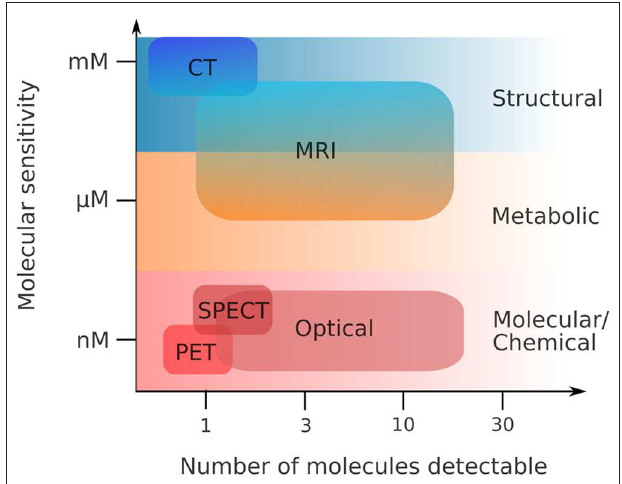
FIGURE 2 | Functional imaging—sensitivity vs. specificity. Same abbreviations as in Figure 1 . Adapted from Pogue et al. [1], with permission from the American Journal of Roentgenology (copyright owner).